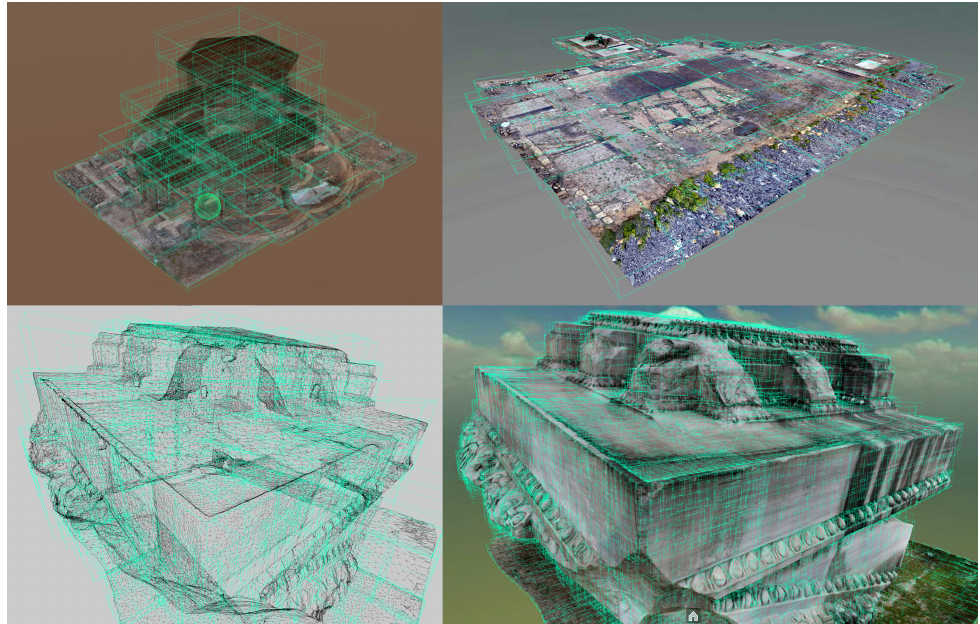
Figure 10. Sample BVH trees in ATON (green) to accelerate 3D